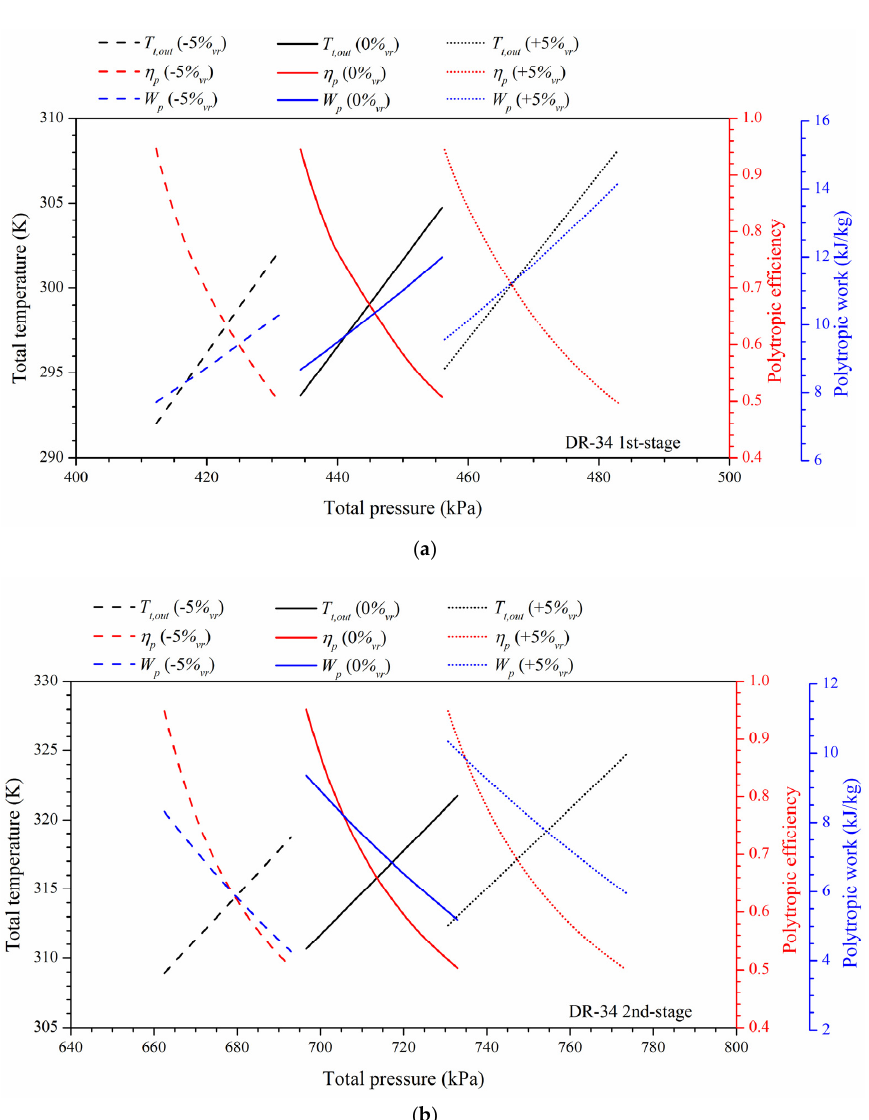
Figure 7. Comparison of outlet total temperature, polytropic efficiency, and polytropic work for a permissible range of − 5 % vr to +5 % vr for DR-34. ( a ) First-stage compressor at Φ = 0.036 and ( b ) second-stage compressor at Φ = 0.026.